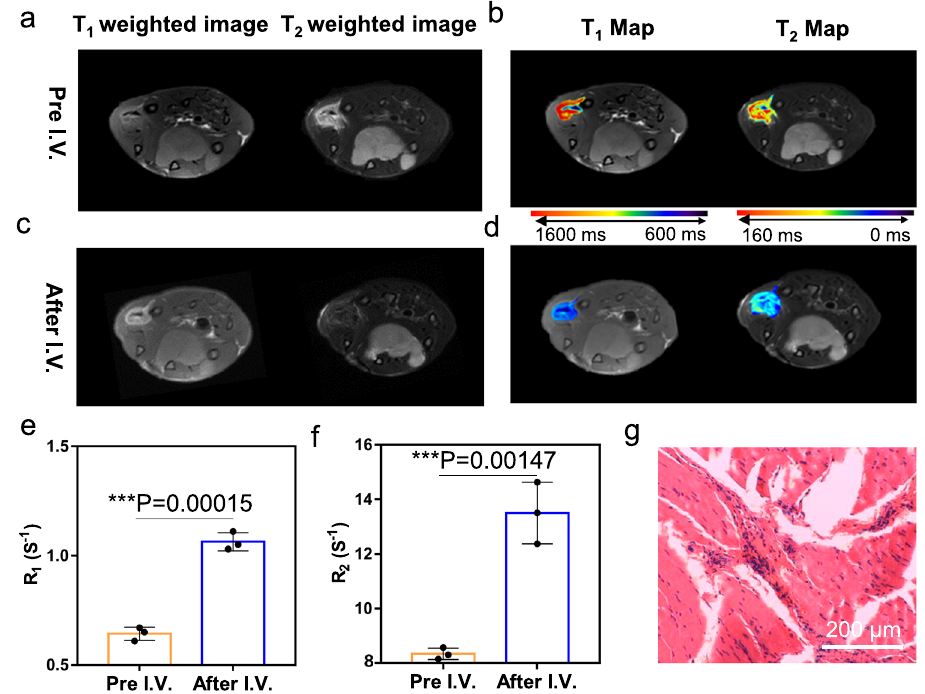
Fig. 7 | SSM-PEG (PEG-modi fi ed SPIO@SiO 2 @MnO 2 ) for MRI diagnosis of in fl ammation in vivo. a T 1 and T 2 weighted images and b T 1 & T 2 Map of muscle in fl ammation without the use of contrast agents. Representative data are shown from three mice samples. c T 1 and T 2 weighted images and d T 1 and T 2 Map of musclein fl ammationoftheratsreceivingI.V.injectionofSSM-PEG.Representative data are shown from three mice samples. e R 2 and f R 1 at the muscle in fl ammation